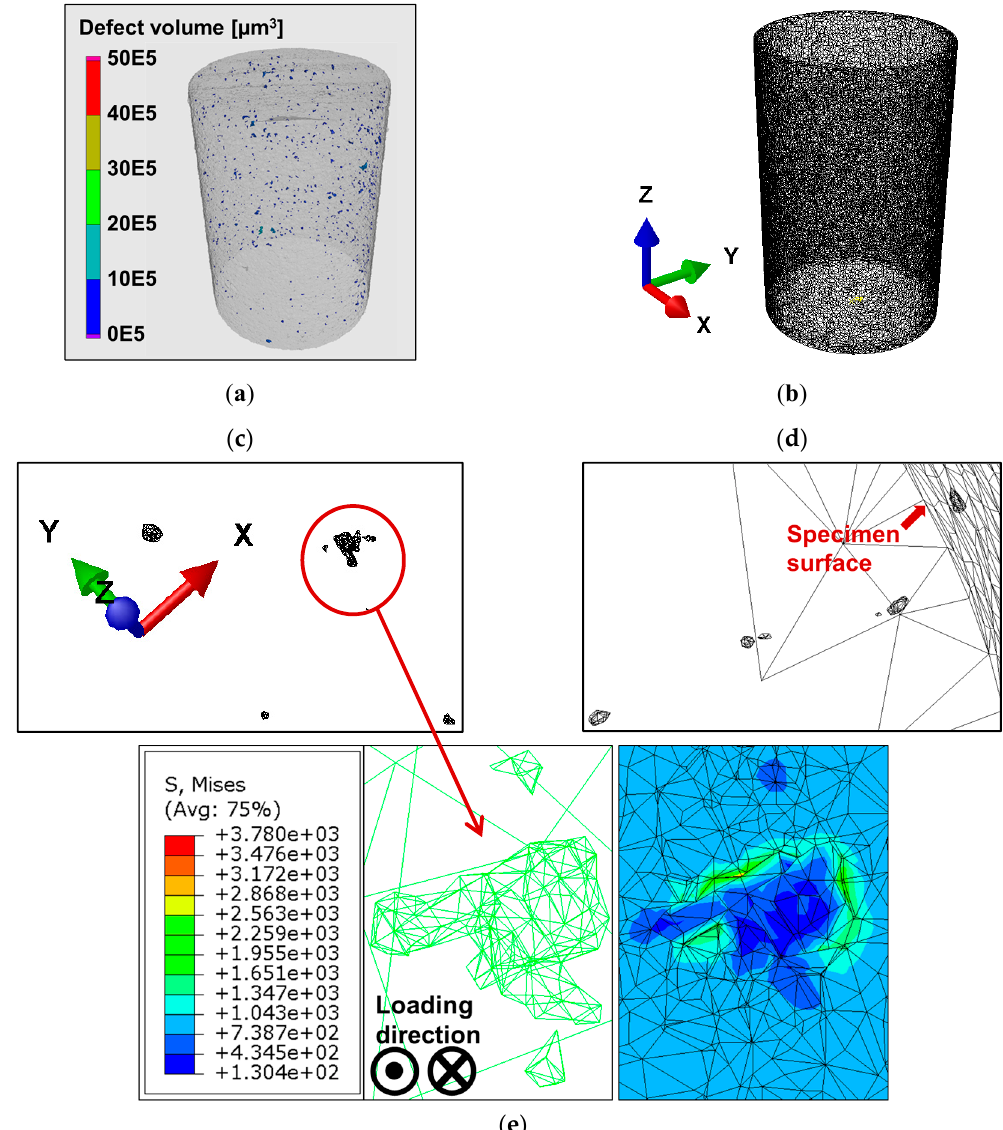
Figure 8. Process chain of porosity analysis from microcomputed tomography (µ-CT) scan until stress calculation around internal remnant pores when the applied remote stress amplitude is 800 MPa: ( a ) 3D defect volume distribution; ( b ) 3D surface tessellation of the scanned volume; ( c ) clusters of defects concerning the coordinate system in the bulk of the scanned volume; ( d ) multiple defects at different depth levels from the surface (surface is at the top right) respecting the same triad in ( c ); ( e ) stress concentration at a cluster of non-spherical defects.